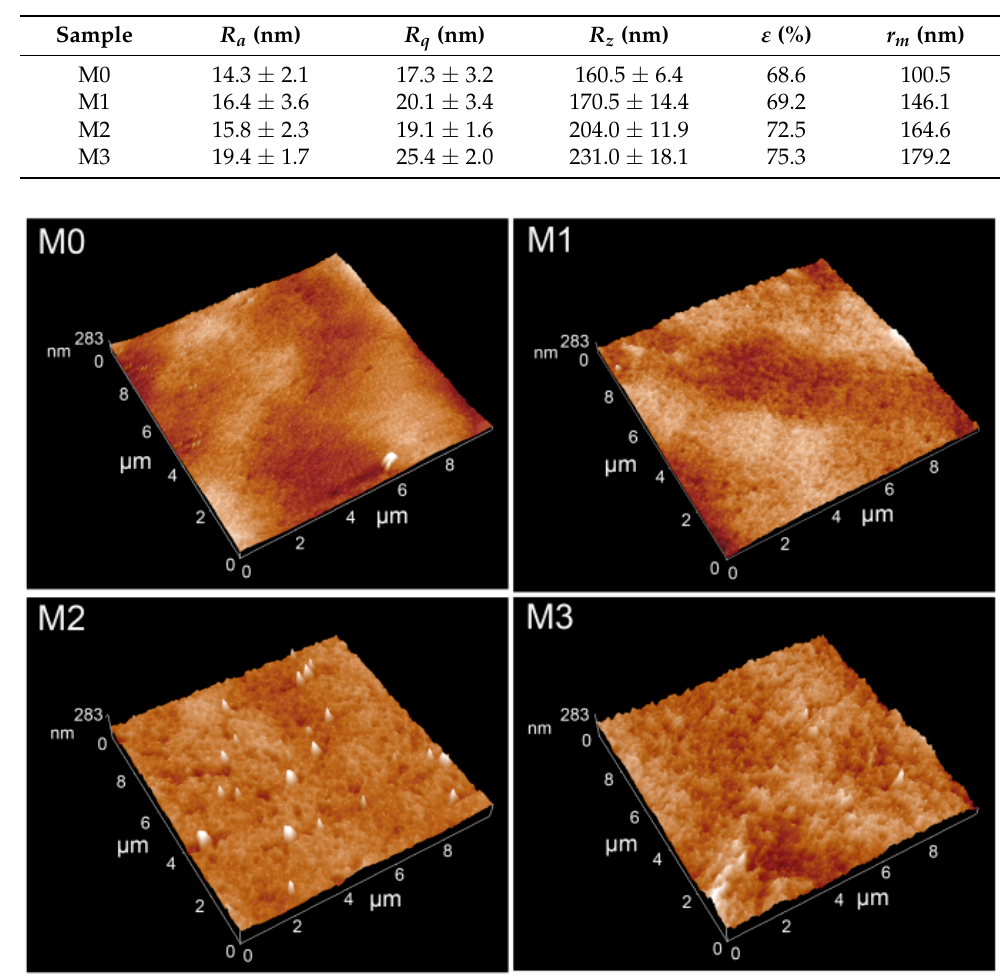
Table 3. Roughness parameters, porosity and pore sizes of hybrid membranes.